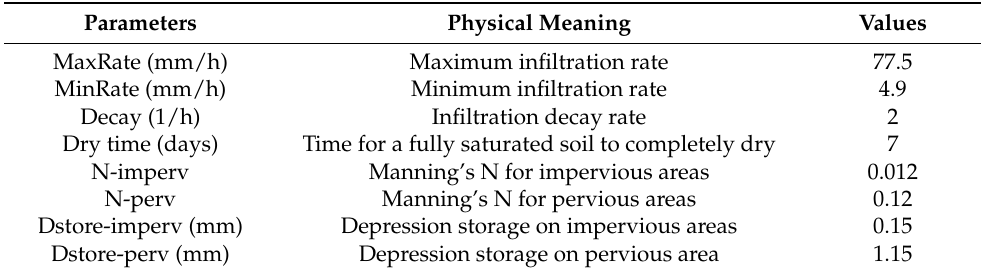
Figure 5. Comparison of simulated and observed values during rainfall events: ( a ) Calibration for TSS concentration; ( b ) Calibration for runoff volume; ( c ) Validation for TSS concentration; ( d ) Validation for runoff volume. Table 3. Hydrology parameters of the